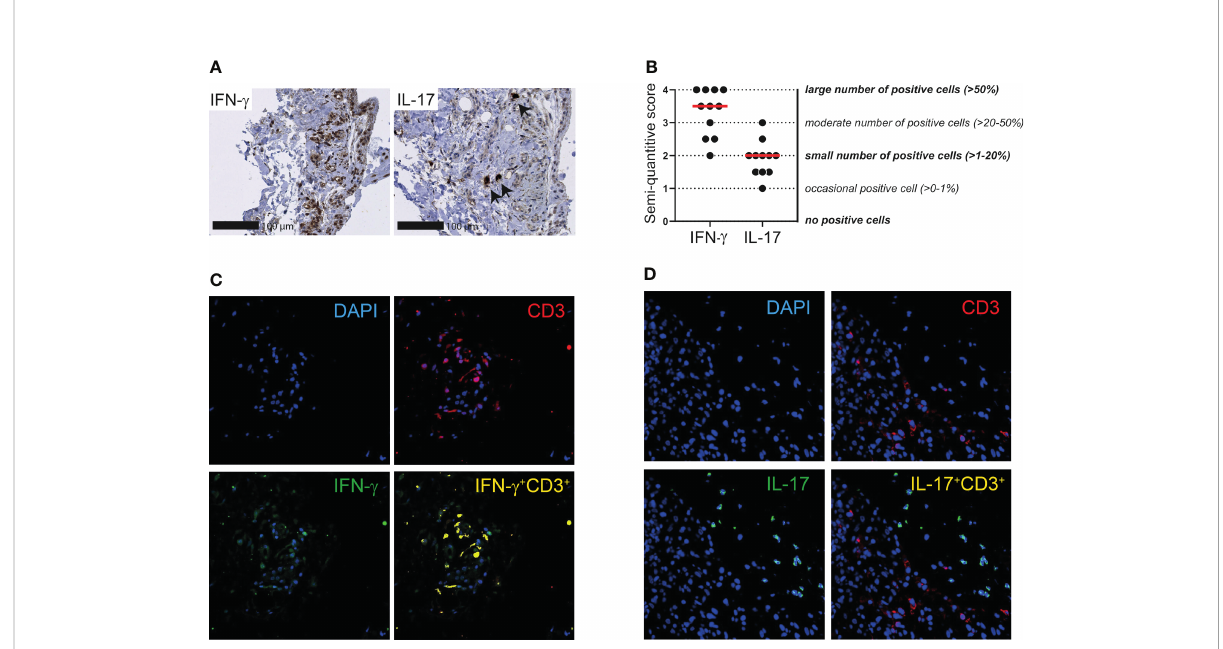
FIGURE 6 IFN- g and IL-17 expression by T cells in synovial tissue of patients with PMR. (A) Representative immunohistochemistry staining for IFN- g (left panel) and IL-17 (right panel) in the synovial biopsy of a patient with PMR. Arrows indicate IL-17 + cells. (B) Semi-quantitative scoring for IFN- g and IL-17 in bursa tissue biopsies of 11 patients with PMR. The scores of two independent investigators were averaged. (C) Representative immuno fl uorescence staining for colocalization of IFN- g and CD3 (yellow) in the bursa tissue biopsy of a patient with PMR. CD3 (red) and IFN- g (green) single staining are also shown together with DAPI counterstaining (blue). (D) Representative immuno fl uorescence staining for colocalization of IL-17 and CD3 (yellow) in the bursa tissue biopsy of a patient with PMR. CD3 (red) and IL-17 (green) single staining are also shown together with DAPI counterstaining (blue). Representative immuno fl uorescence images of two other patients are shown in Supplementary Figure S9. Images are shown at 40x magni fi